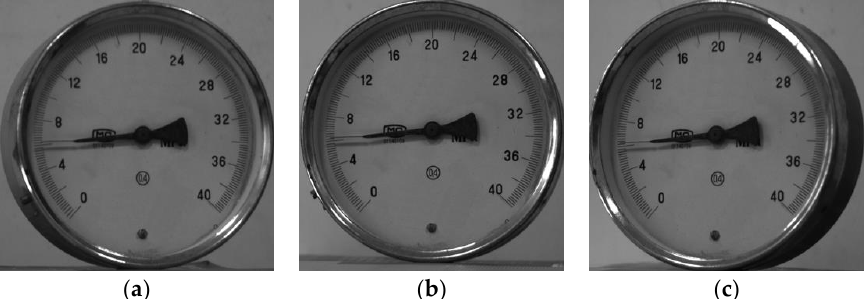
Figure A2. The meter image taken by camera from three angles when the reading of the pointer meter is 6.2; ( a ) the camera at position 1; ( b ) the camera at position 2; ( c ) the camera at position 3.